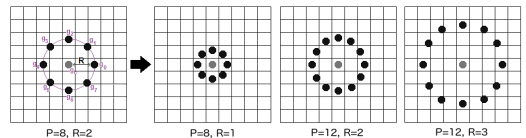
Fig.7. represents the various di ff erent parameters includ- ing Sensitivity, Specificity, Precision, F1 score, Accuracy etc that were calculated with the help of the number of images tested with the model. Similarly, the Confusion Matrix shown in